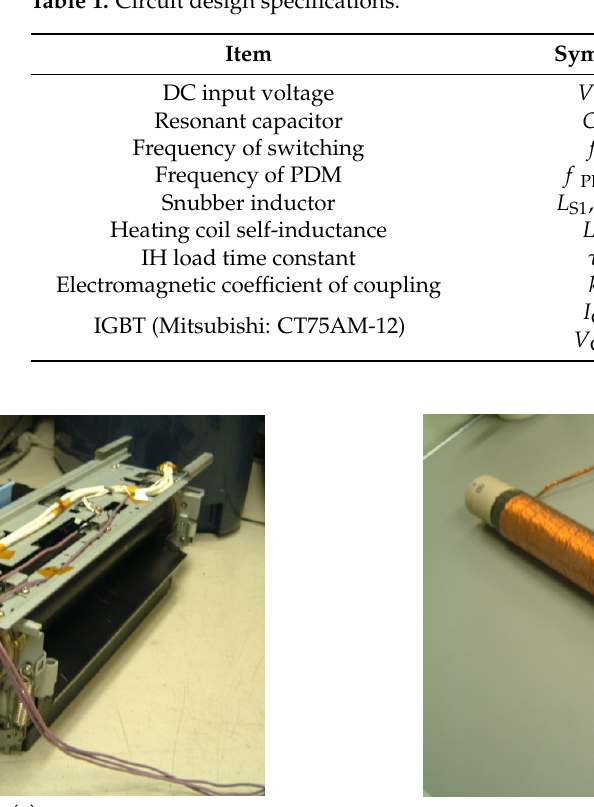
Table 1. Circuit design specifications.